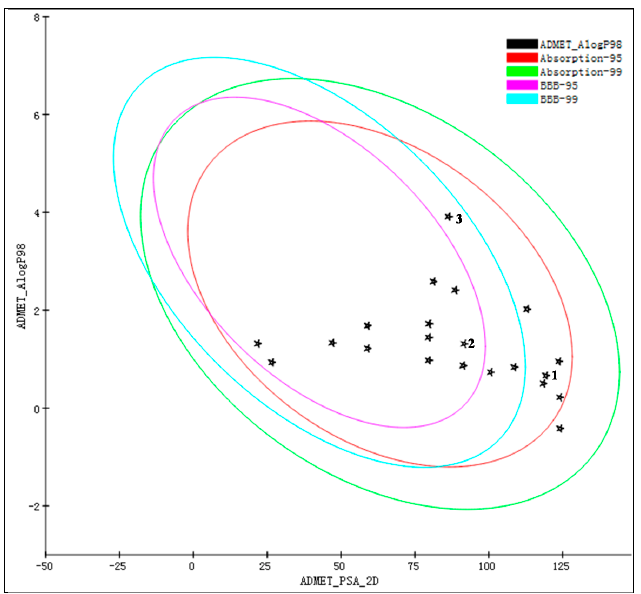
Figure 1 . Relationship between the two-dimensional polar surface area (PSA_2D) and the calculated value of AlogP98 of 23 candidate compounds selected after absorption, distribution, metabolism, excretion, and toxicity (ADME/T) screening, showing the corresponding blood–brain barrier (BBB) penetration and human intestinal absorption (HIA) model 95% and 99% confidence ellipses.